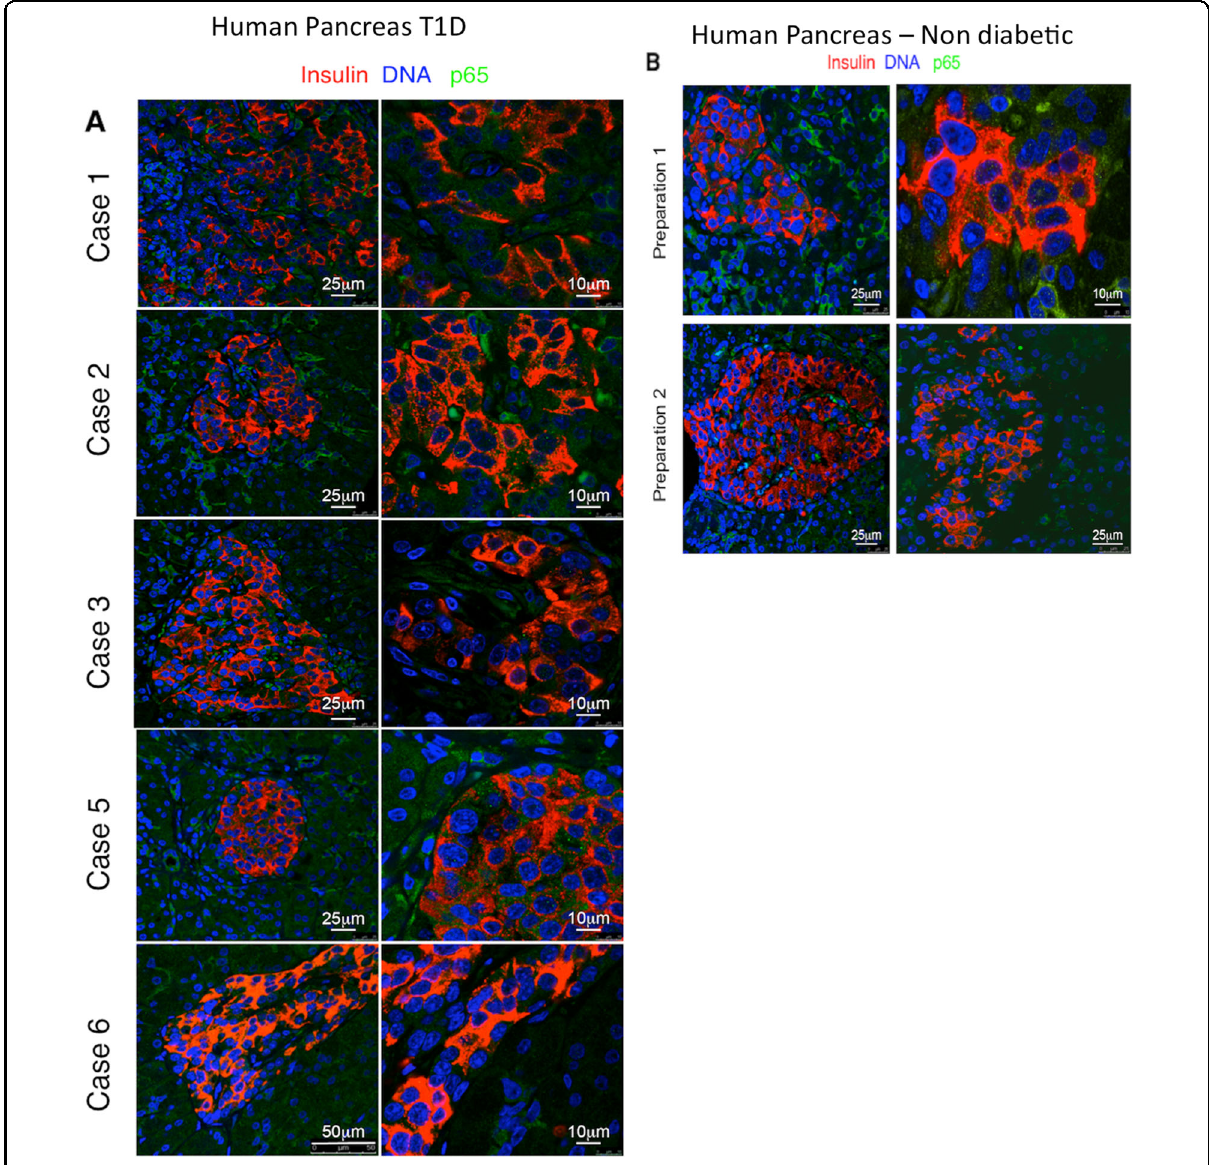
Fig. 8 Immunolocalization of the NF- κ B p65-subunit in the pancreas of recently diagnosed human T1 patients. A Laparoscopic pancreatic tail resection samples of fi ve T1D patients (Divid-Study Patient cases 1 – 3, 5, 6) and B of two representative non-diabetic pancreata were immunostained for p65 (green), insulin (red), and DNA (blue). Pictures are representative confocal images of islets from 9 to 27 islets per group. Original images were taken at a magni fi cation of ×25 left panel and ×10 right